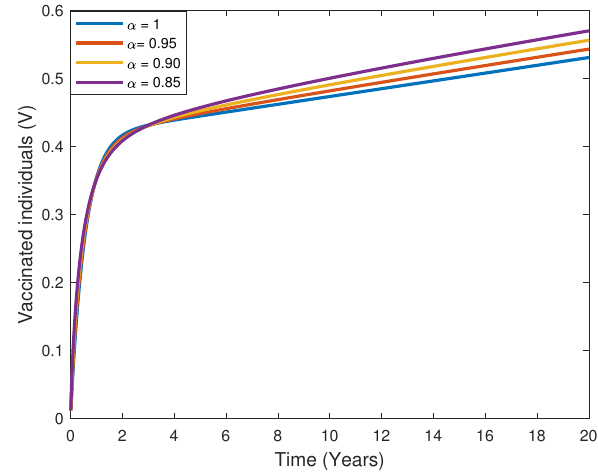
Figure 8. Behavior of V class for different α values.